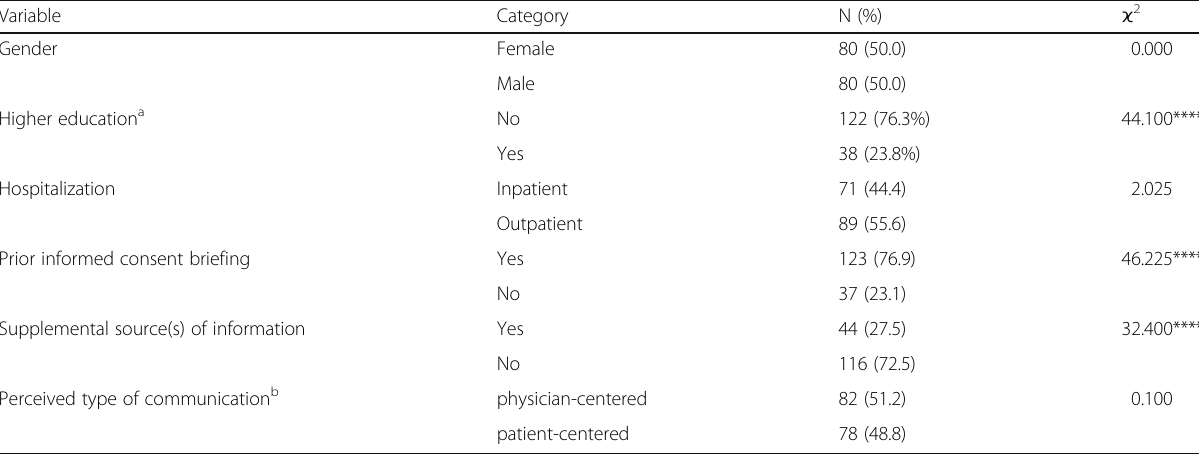
Table 1 Descriptive data and statistical analysis of categorical variables